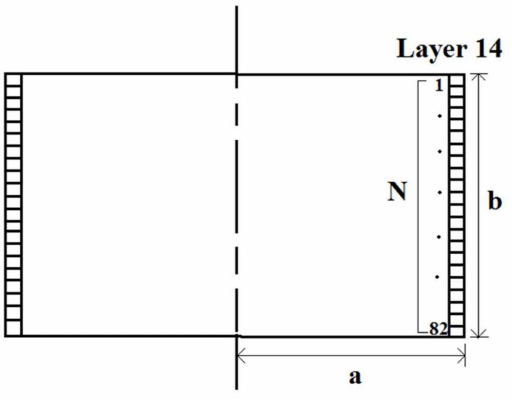
Figure 6. Sectional detail of 14th layer considered as a single layer helical